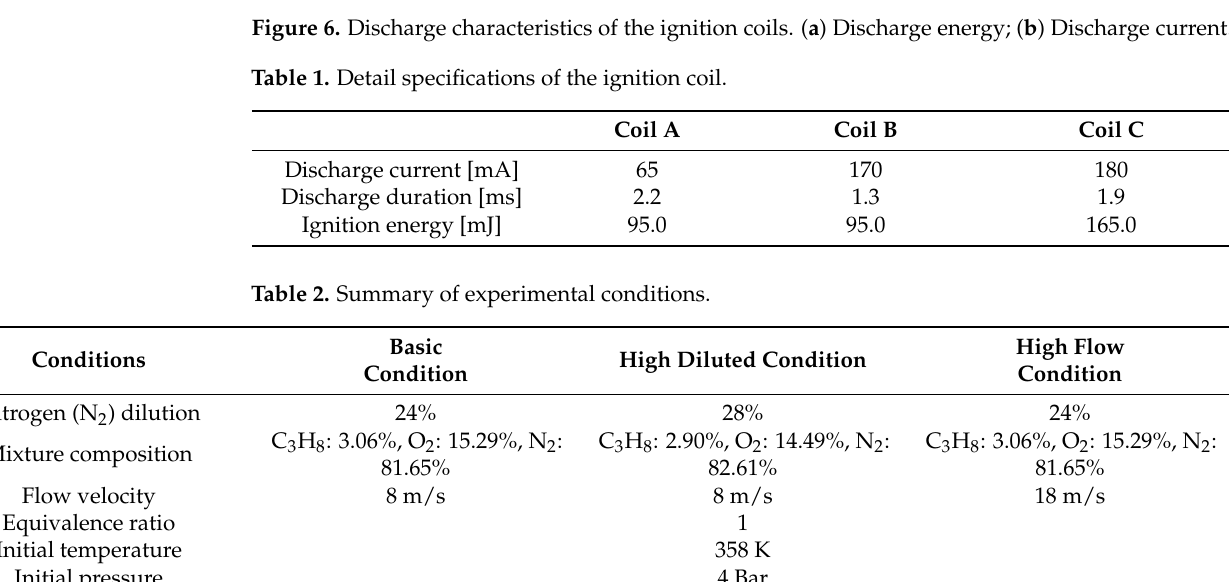
Table 2. Summary of experimental conditions.